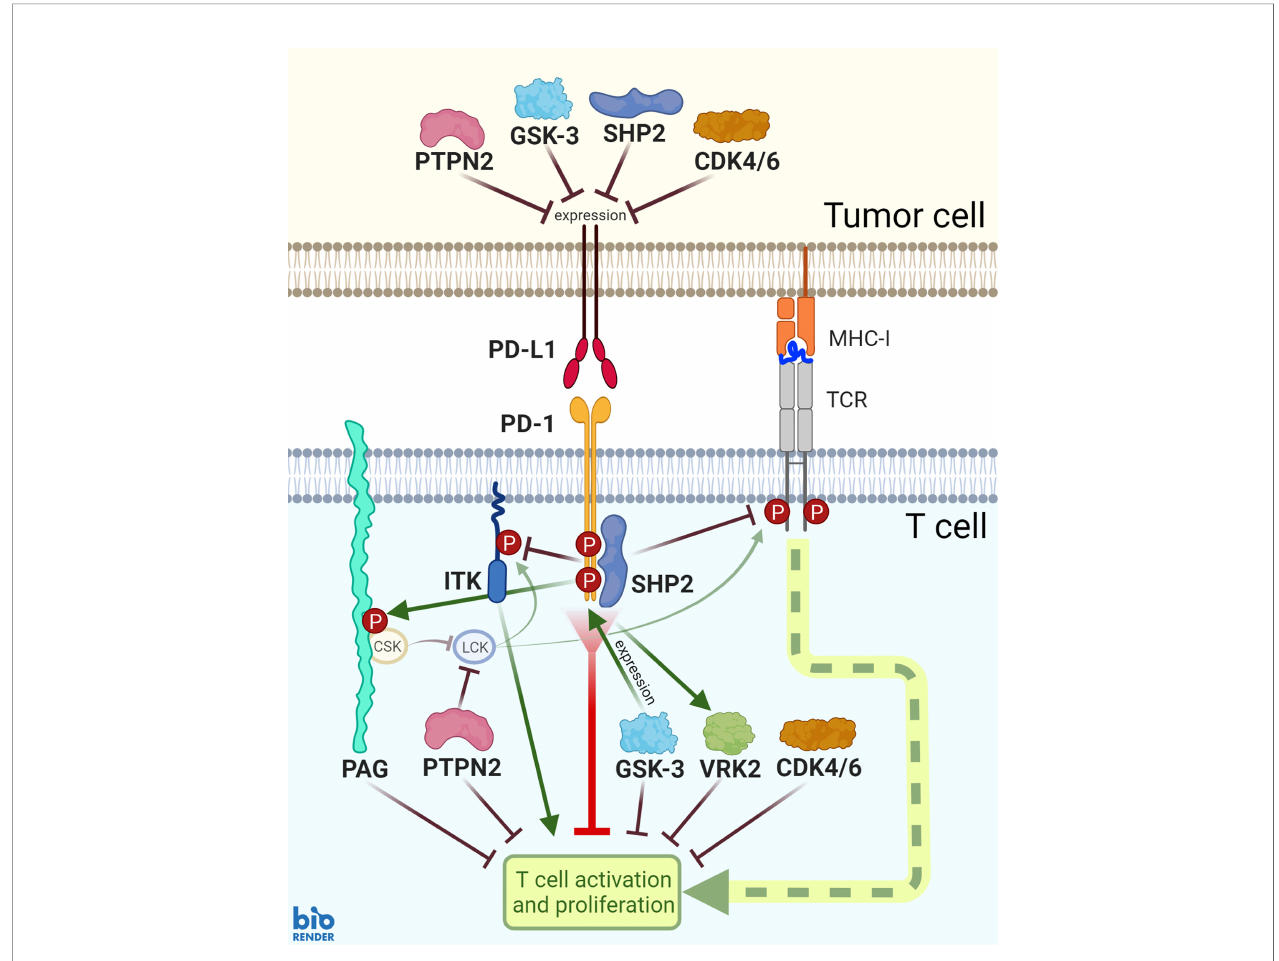
FIGURE 1 | PD-1 functions and PD-L1 expression are mediated by SHP2, PTPN2, PAG, ITK, GSK-3, VRK2, and CDK4/6 signaling. SHP2 is recruited downstream of PD-1 ligation and mediates a number of subsequent signaling events. Additionally, PD-1 ligation is associated with enhanced activity of inhibitory proteins PAG and VRK2 and inhibition of ITK. GSK-3 activates transcription factors to induce PD-1 expression; while GSK-3, PTPN2, SHP2, and CDK4/6 inhibit PD-L1